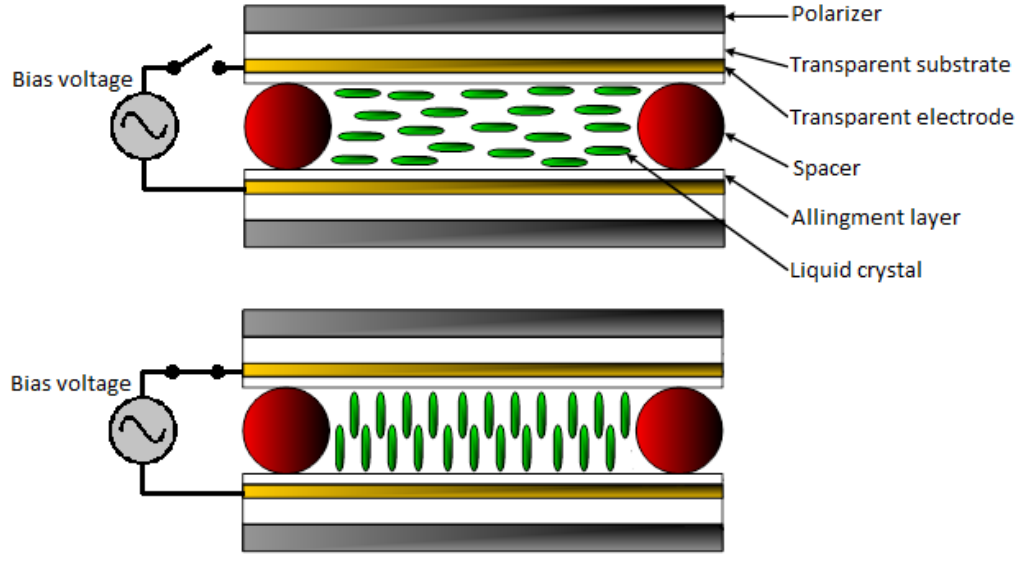
Figure 1. Structure and working principle of a homogeneously aligned nematic liquid crystal